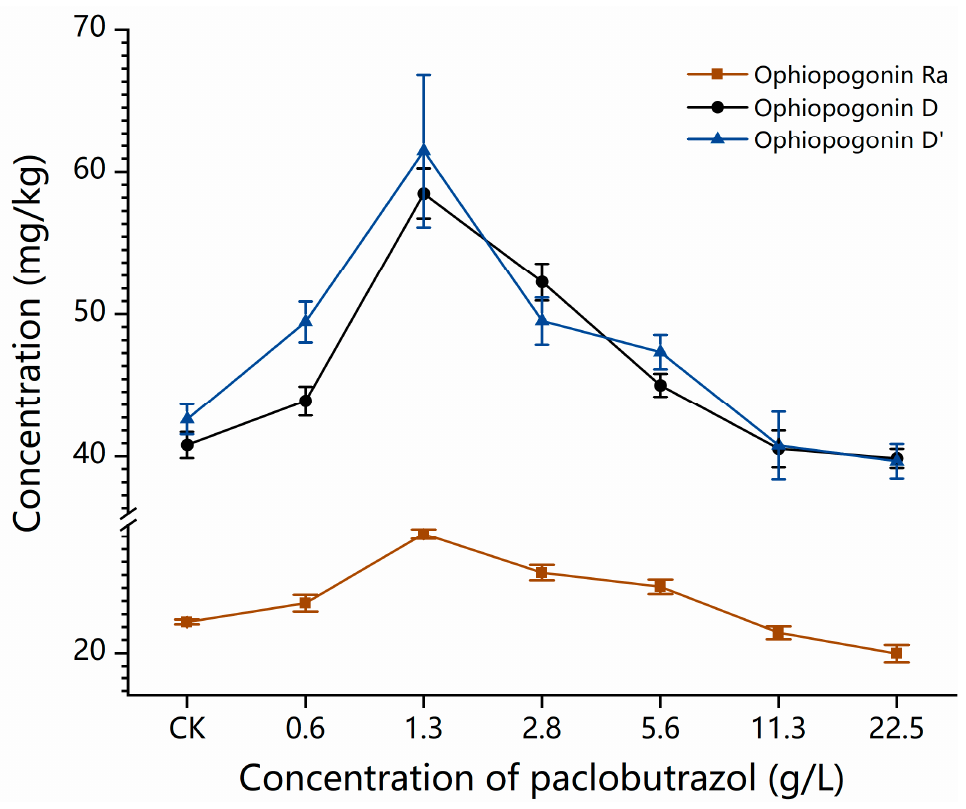
Figure 7. Effects of paclobutrazol at different concentrations on the contents of Ophiopogonin D, Ophiopogonin D’, and Ophiopogonin Ra. Vertical bars represent standard errors.